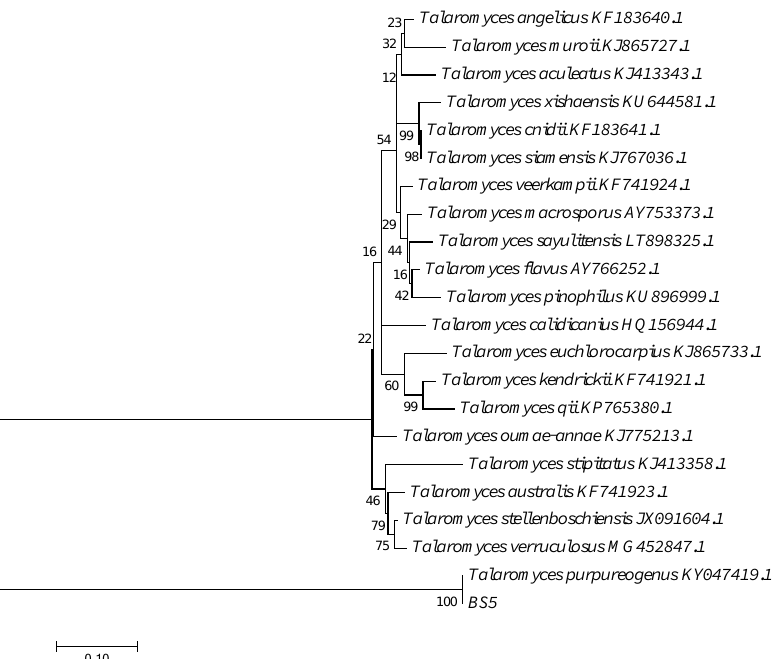
Figure 7. The Maximum Likelihood method phylogram yielded from partial β -tubulin sequence data set.